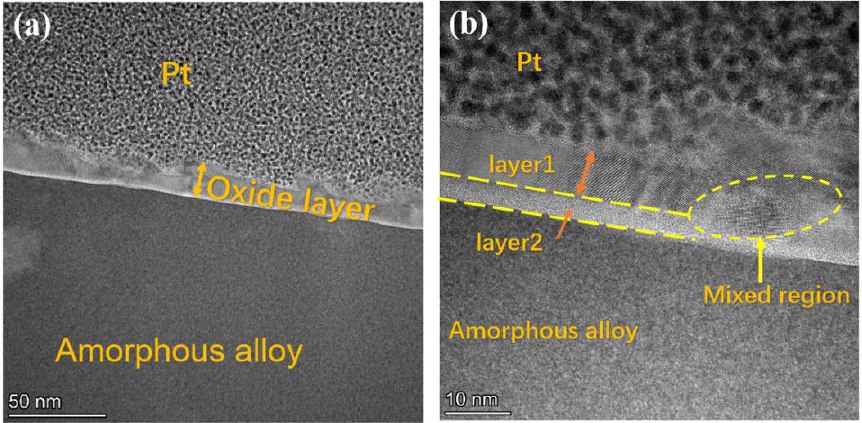
Figure 9. TEM image of the ribbon after pre-oxidation heat treatment at 280 °C for 60 min. ( a ) Surface structure diagram; ( b ) oxide layer structure diagram.